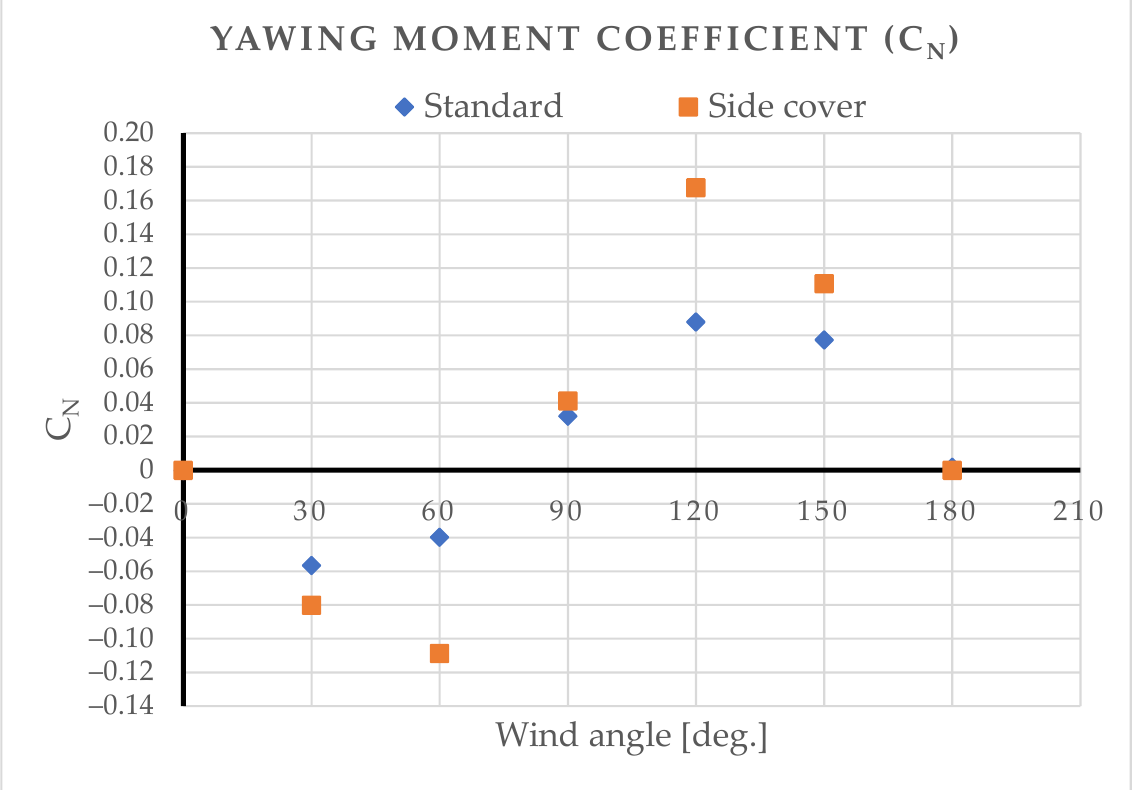
Figure 35. Effect of side covers on the side force coefficient at different wind angles.